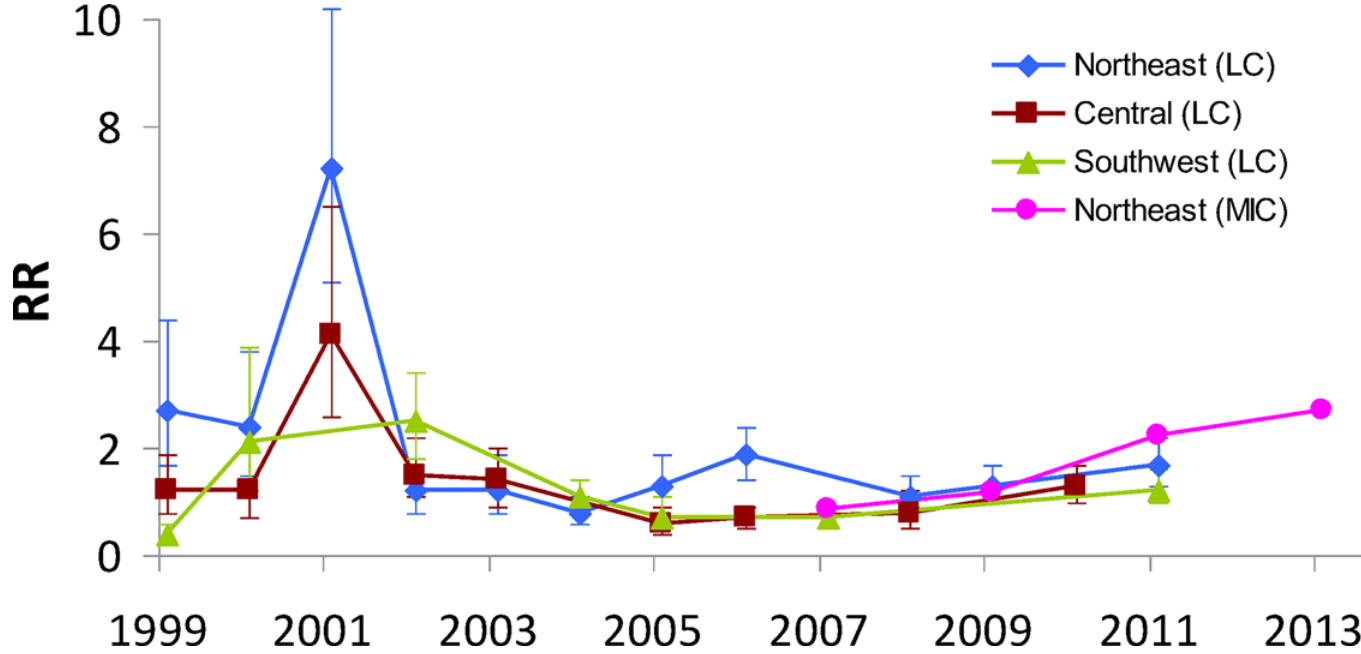
Fig 2. Susceptibility to Cry1Ab of Spanish field populations of Sesamia nonagrioides . Resistance Ratios (RR) with respect to a susceptible laboratory strain were calculated from: LC 50 data of field populations from northeast, central and southwest Spain in the period 1999 – 2011 (see Table A in S1 File); and MIC 50 data reported in the resistance monitoring programme undertaken by Monsanto Europe S.A. for field populations from northeast Spain in the period 2007 – 2013 (in EFSA, 2015 [18]). Error bars correspond to confidence limits at 95% for RR values calculated from LC 50 values.